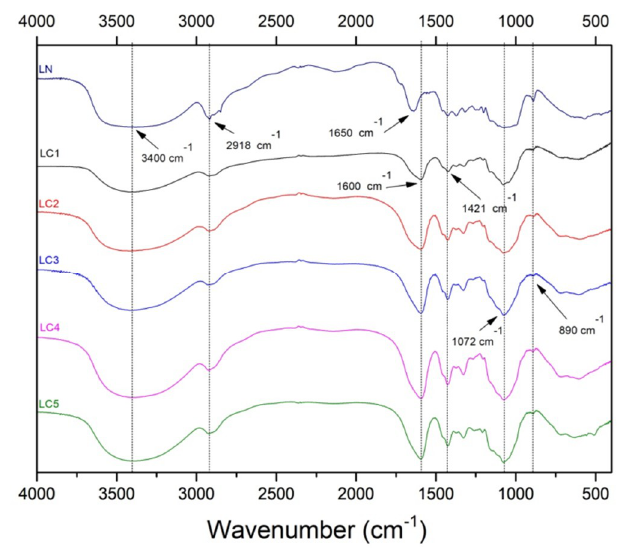
Figure 2. FTIR spectra of LN and LC1 (DS: 0.32), LC2 (DS: 0.47), LC3 (DS: 0.51), LC4 (DS: 0.58), and LC5 (DS: 0.68).